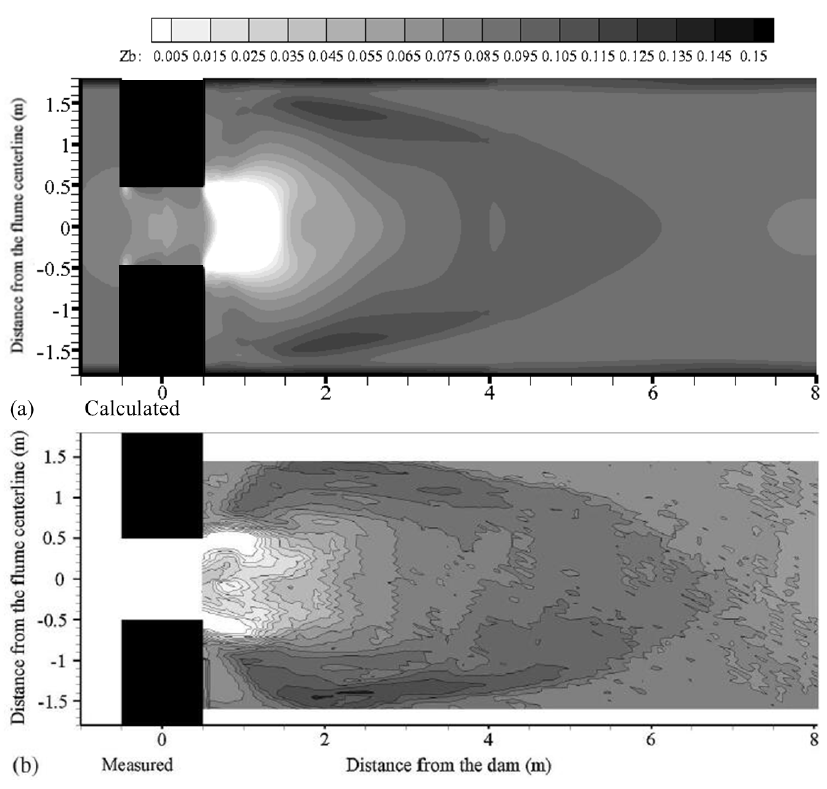
Figure 15. Calculated ( a ) and measured ( b ) topography at t = 20 s.